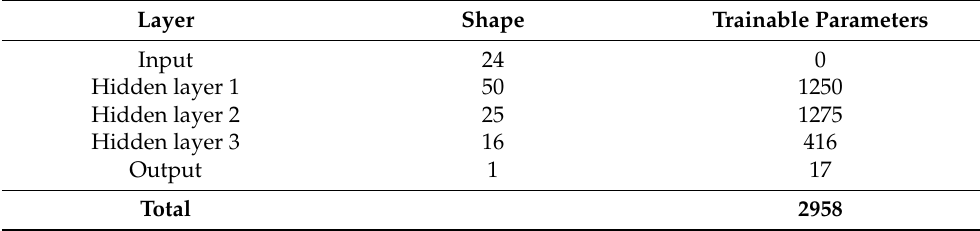
Table 2. The number of trainable parameters of the proposed OFDF model without PCA.